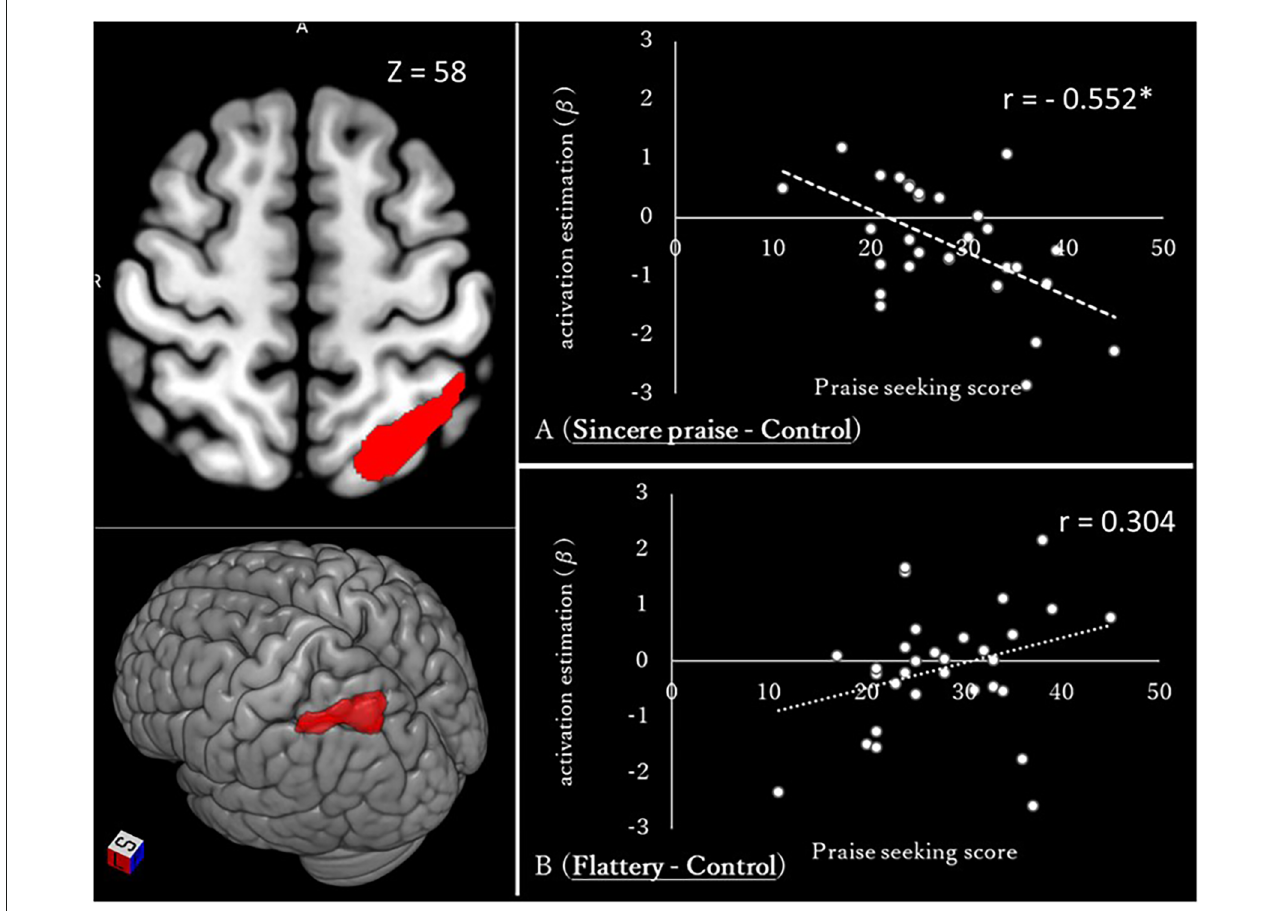
FIGURE5 Whole-brain regression analysis of praise-seeking (sincere praise − flattery) and correlation between brain activation and the praise-seeking score [(sincere praise − control) and (flattery − control)] The images on the left show the intraparietal sulcus, the activity in which was identified using whole-brain regression analysis according to praise-seeking and speed-distinctive (slow) contrasts [cluster-defining threshold: uncorrected p - value < 0.001, derived from p < 0.05 based on via family-wise error (FWE)]. Brains were mapped onto the MNI template brain using MRIcroGL (https://www.mccauslandcenter.sc.edu/mricrogl/home). Diagrams on the right show the correlation between brain activation and the praise-seeking trait ( ∗ p <